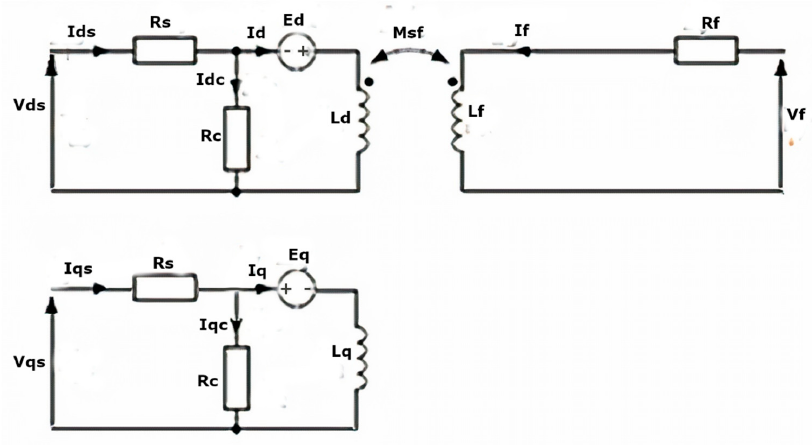
Figure 2. HEPMSM equivalent circuit including core loss resistance.